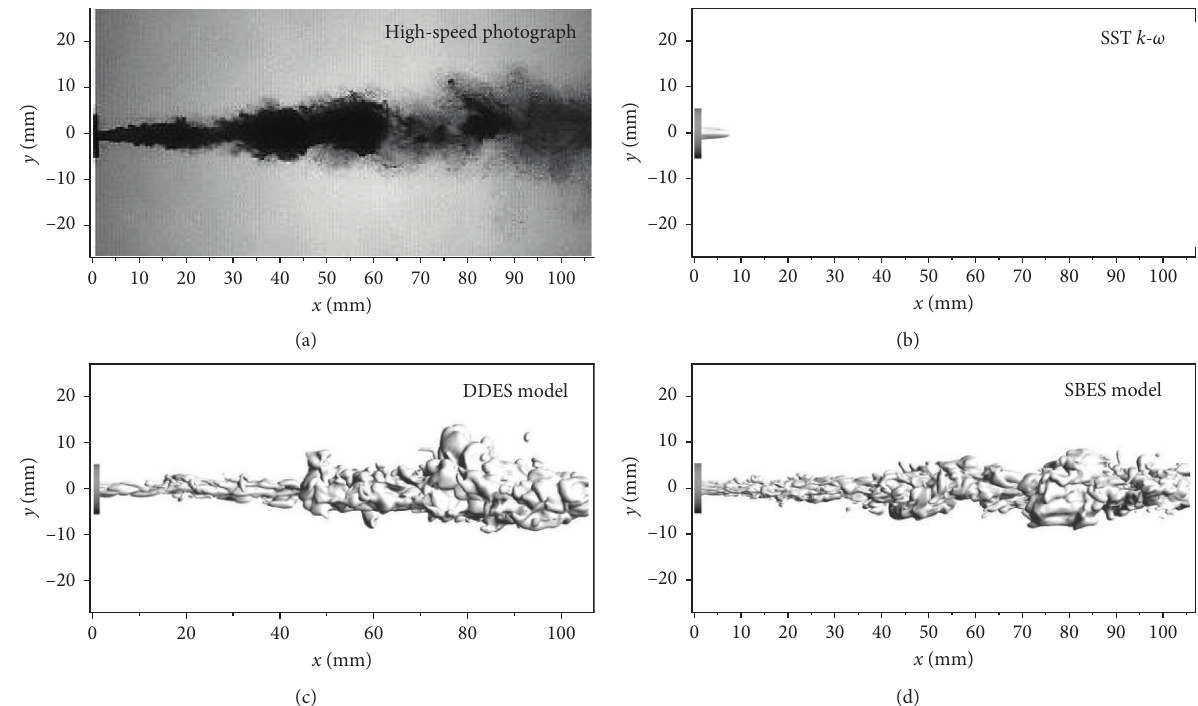
Figure 10: Morphology of the cavitation clouds by experiment and CFD.